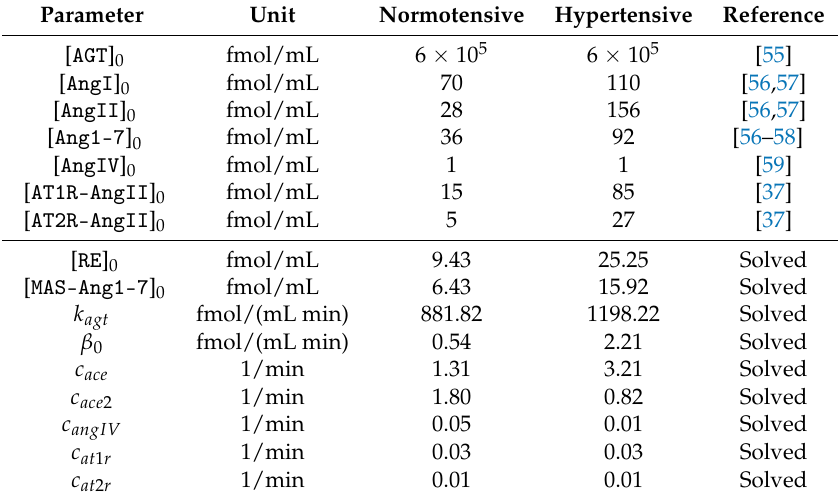
Table 2. Equilibrium concentrations of the species involved in RAS and production and reaction rate parameters, for healthy normotensive and hypertensive humans. “Solved” means solved from the